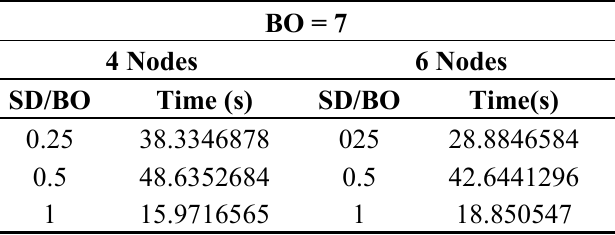
Table 7. Average set-up time. BO = 7.